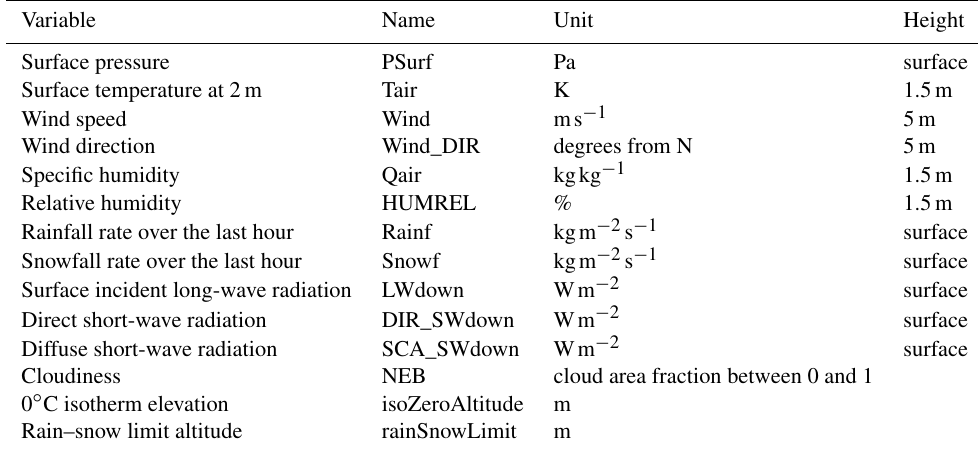
Table 3. List of SAFRAN output variables, at an hourly time